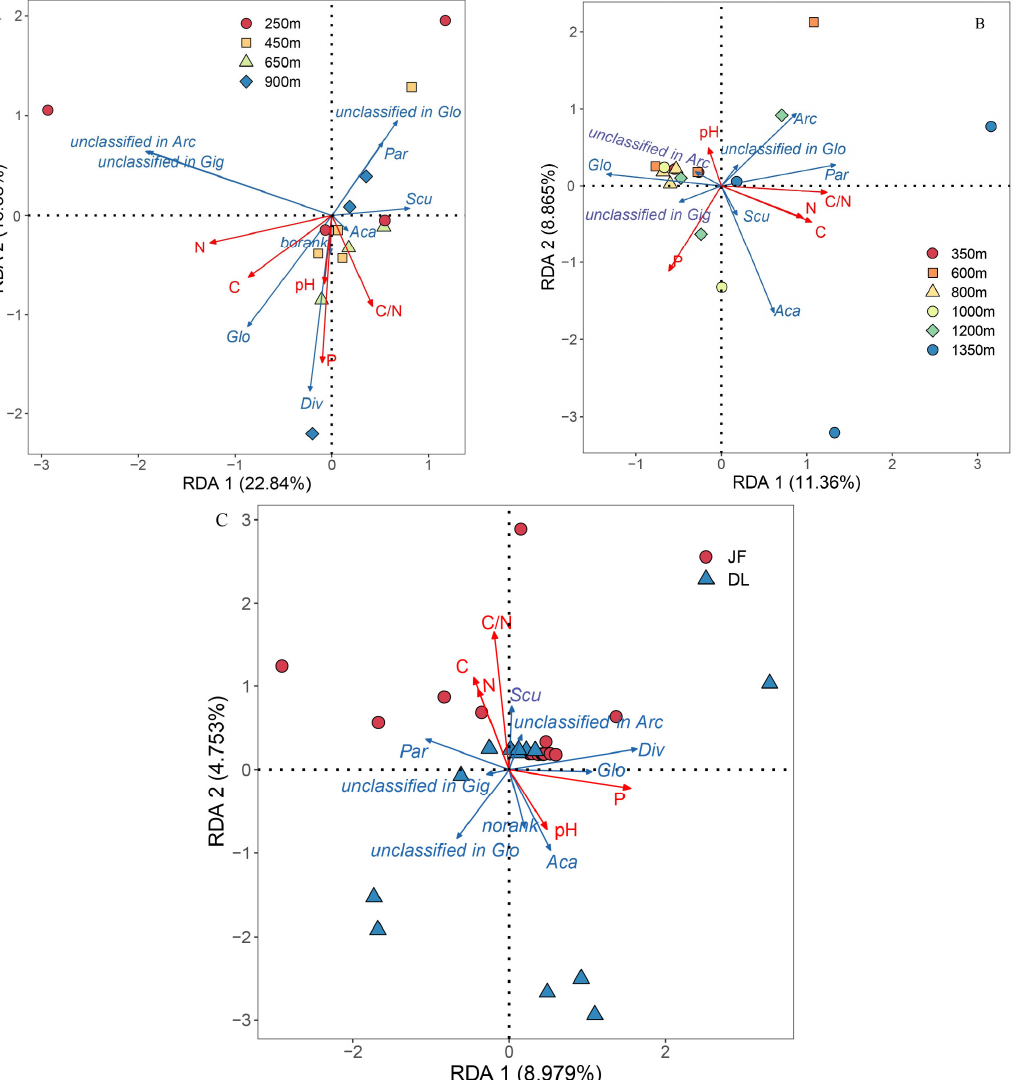
Figure 5. Graphical representations of the redundancy analysis (RDA) for AMF genera and soil properties of C, N, P, pH and C/N on Mt. Diaoluo ( A ), Mt. Jianfengling ( B ) and the two mountains ( C ). Genera: Aca ( Acaulospora ), Arc ( Archaeospora ), Div ( Diversispora ), Glo ( Glomus ), norank , Par ( Paraglomus ), Scu ( Scutellospora ), unclassified in Glo ( unclassified in Glomeromycetes ), unclassified in Arc ( unclassified in Archaeosporaceae ), unclassified in Gig ( unclassified in Gigasporaceae ).